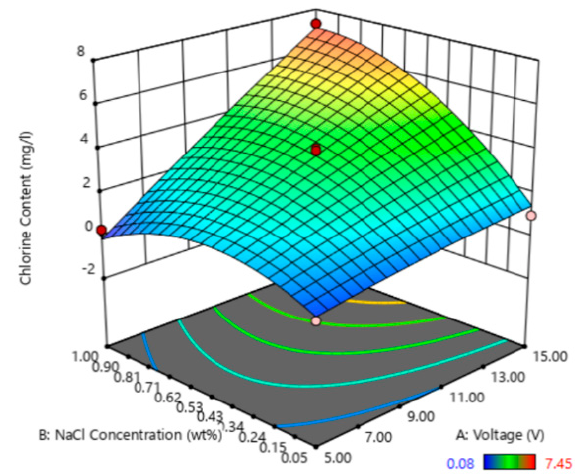
Figure 3. Response surface plot of the ORP of: ( a ) AcEW and ( b ) AlEW due to the combined effect of the NaCl concentration and the voltage.